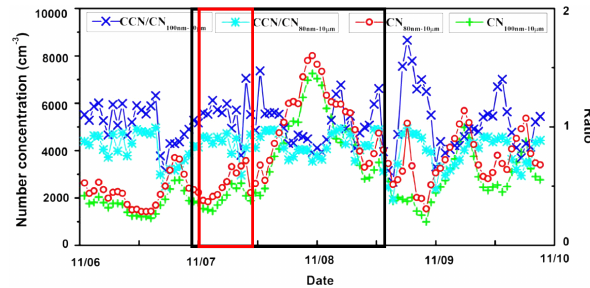
Figure 8. Temporal variations of CN 100nm − 10µm „ CN 80nm − 10µm , CCN / CN 100nm − 10µm at 0.2% SS and CCN / CN 80nm − 10µm at 0.2% SS, the foggy–hazy case is marked in red open boxes and hazy case in